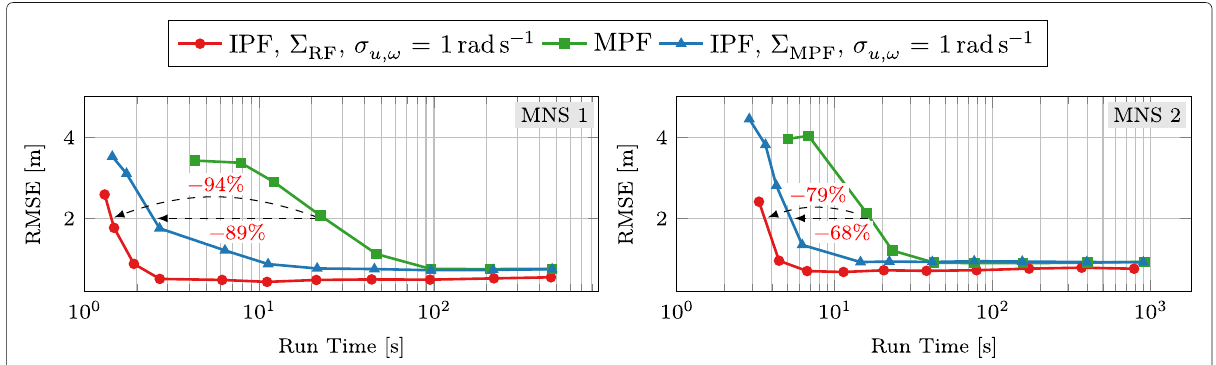
Fig. 8 Run-time comparison between the MPF and IPF algorithms for varying state PPA values. The left panel shows the results for MNS 1, and the right panel shows the results for MNS 2